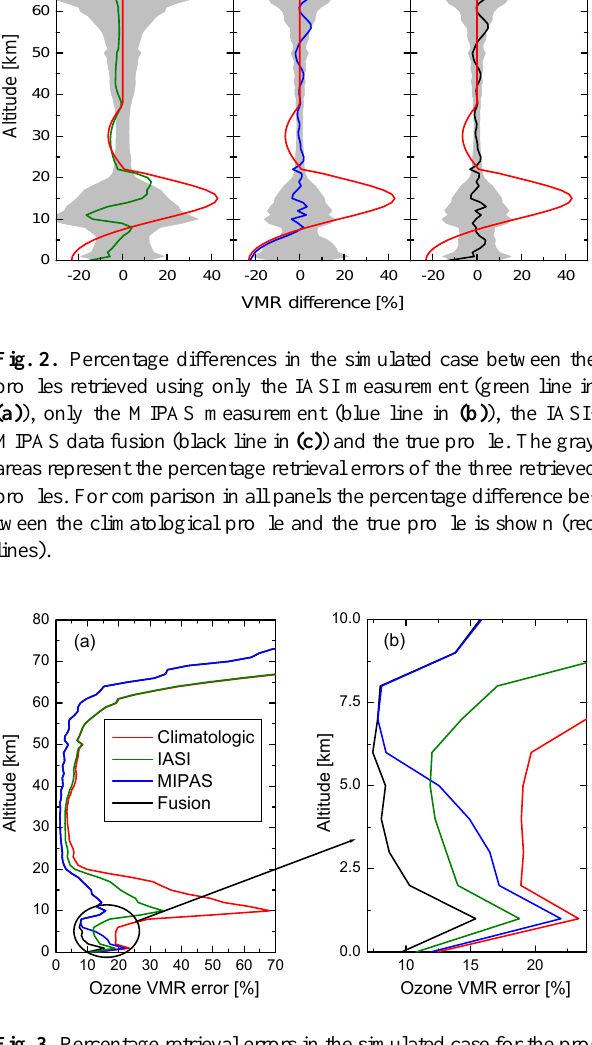
Fig. 3. Percentage retrieval errors in the simulated case for the pro- files retrieved using only the IASI measurement (green line), only the MIPAS measurement (blue line) and the IASI-MIPAS data fu- sion (black line). The standard deviation of the climatological pro- file (red line) is also reported. (b) shows a blow up of (a) in the low altitude